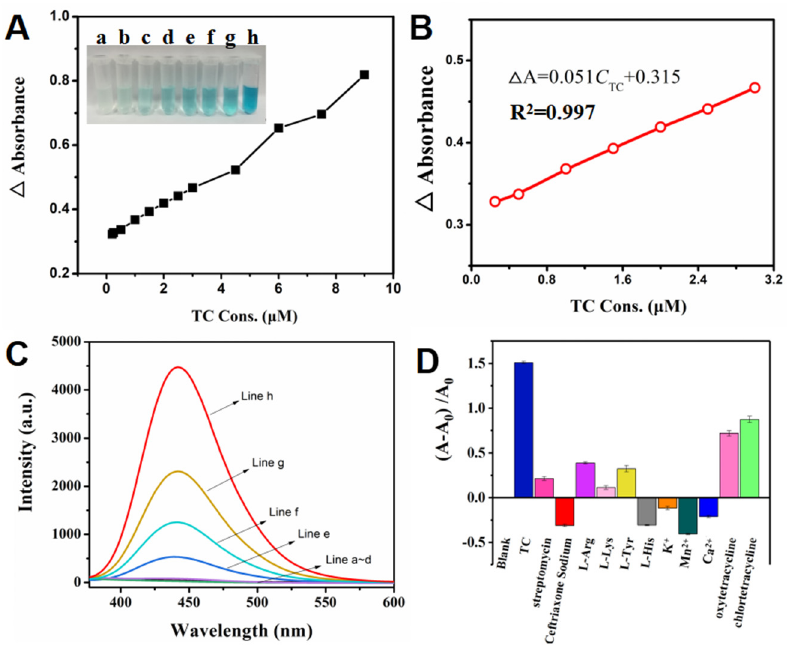
Figure 4. ( A ) Absorbance responses of different concentrations of TC (0.2, 0.25, 0.5, 1.0, 1.5, 2.0, 2.5, 3.0, 4.5, 6.0, 7.5, and 9.0 µM), and the colorimetric responses (inset a~h: blank, 0, 1.0, 2.0, 3.0, 4.5, 6.0, and 7.5 µM); ( B ) the linearity of the concentration responses of TC; ( C ) fluorescence responses of TA